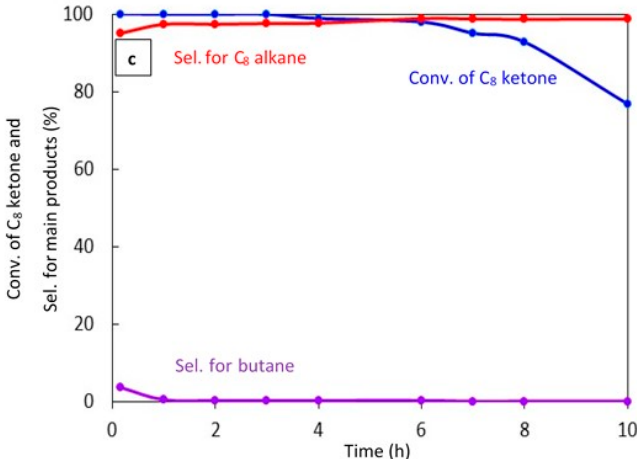
Figure 7. Catalytic results for the conversion of the C 8 ketone to several products with time using 0.5 g of catalysts: ( a ) (20% Cu–Al 2 O 3 ), calcination time (4 h); ( b ) (20% Cu–Al 2 O 3 ), calcination time (8 h); ( c ) (1% Pt–Al 2 O 3 ), calcination time (4 h). Reaction conditions: reaction temperature, 220 °C; the total flow rate of H 2 and N 2 , 85 mL / min; the flow rate of C 8 ketone, 1 mL / h; the molar ratio of H 2 / C